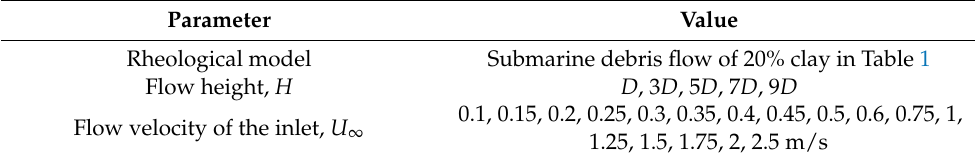
Table 2. Ranges of submarine debris flow parameters used in